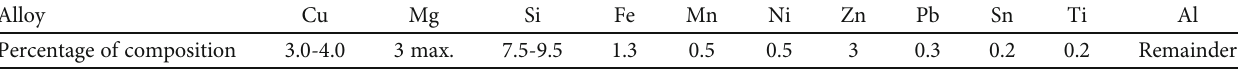
Table 1: Chemical composition of LM 24 aluminium alloy.